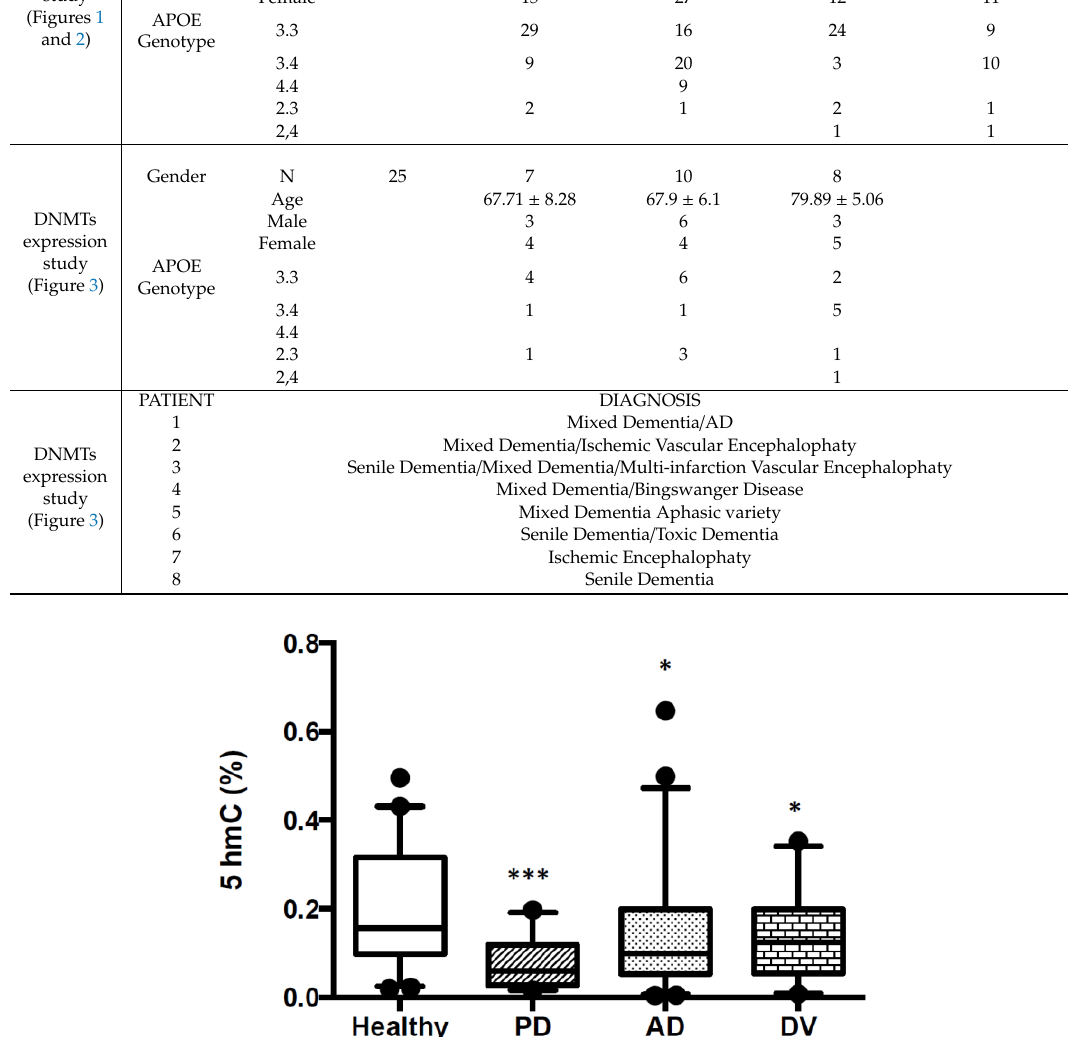
Figure 1. 5mC levels in blood DNA samples from healthy subjects and patients with AD, PD or DV. DNA global methylation was determined with an Enzyme-Linked ImmunoSorbent Assay (ELISA)- like colorimetric assay as described in Material and Methods. The study includes 40 patients with AD, 35 with PD, 26 with DV and 40 healthy controls. Data are shown in a box-plot graphic. Statistical significance between groups was calculated with ANOVA and the Bonferroni test and is shown as ** p < 0.01 and ** p < 0.001.